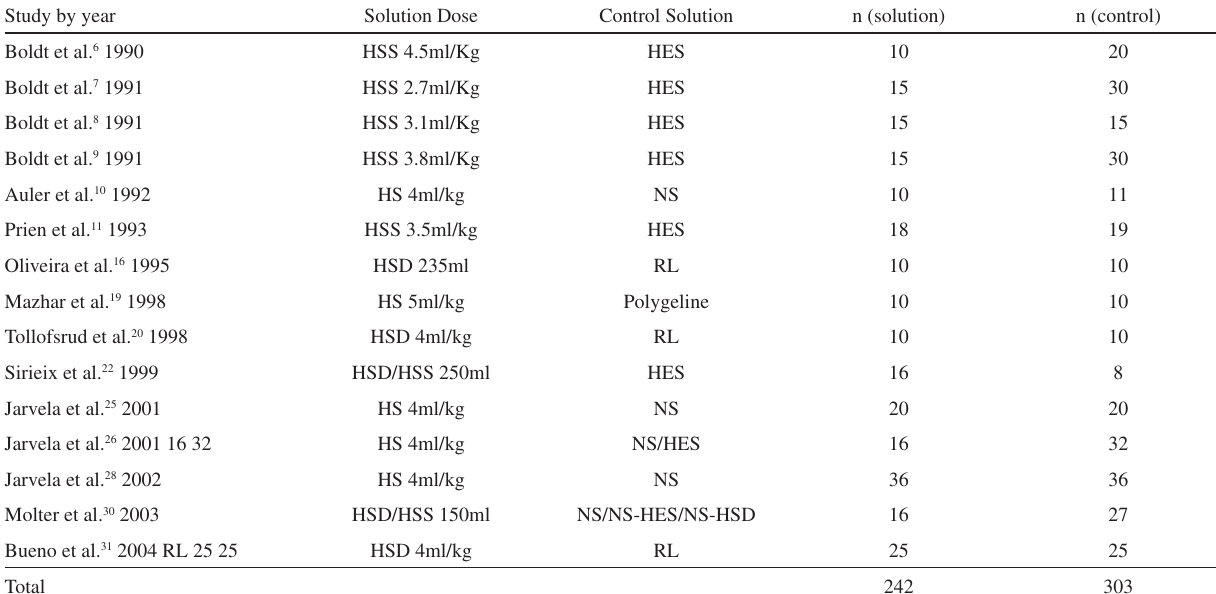
Table 1 - Perioperative studies on the use of hypertonic saline (7.2-7.5% NaCl) alone or in association with either dextran (HSD) or hydroxielthyl starch (HSS) compared to hydroxiethyl starch (HES), Ringer’s solution (RL), normal saline (NS), NS-HSD or polygeline during cardiac surgery